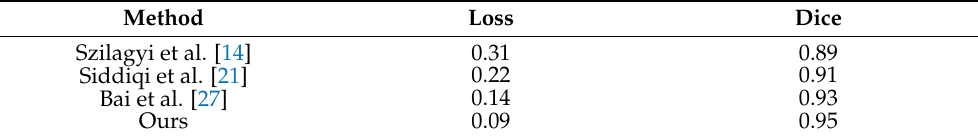
Figure 8. Comparison of network segmentation results. ( a ) Input feature images 1. ( b ) Resulting images of the U-Net network segmentation 1. ( c ) Gold-standard images marked by experts. ( d ) Input feature images 2. ( e ) Resulting images of the U-Net network segmentation 2. ( f ) Gold-standard images marked by experts. Table 2. Comparison between the proposed algorithm and other algorithms.